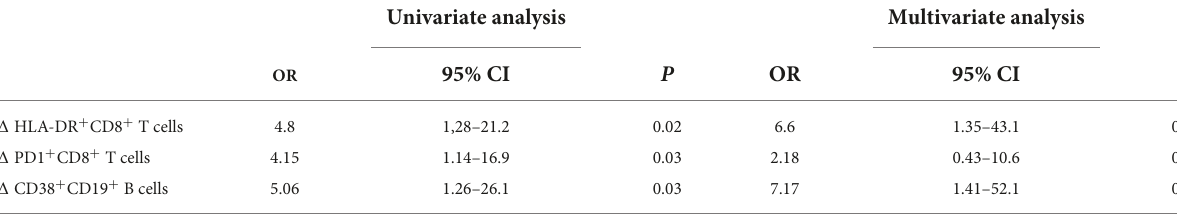
TABLE 3 Factors related to anti–S-RBD IgG formation estimated using univariate and multivariate logistic regression analyses ( n = 42). Univariate analysis Multivariate